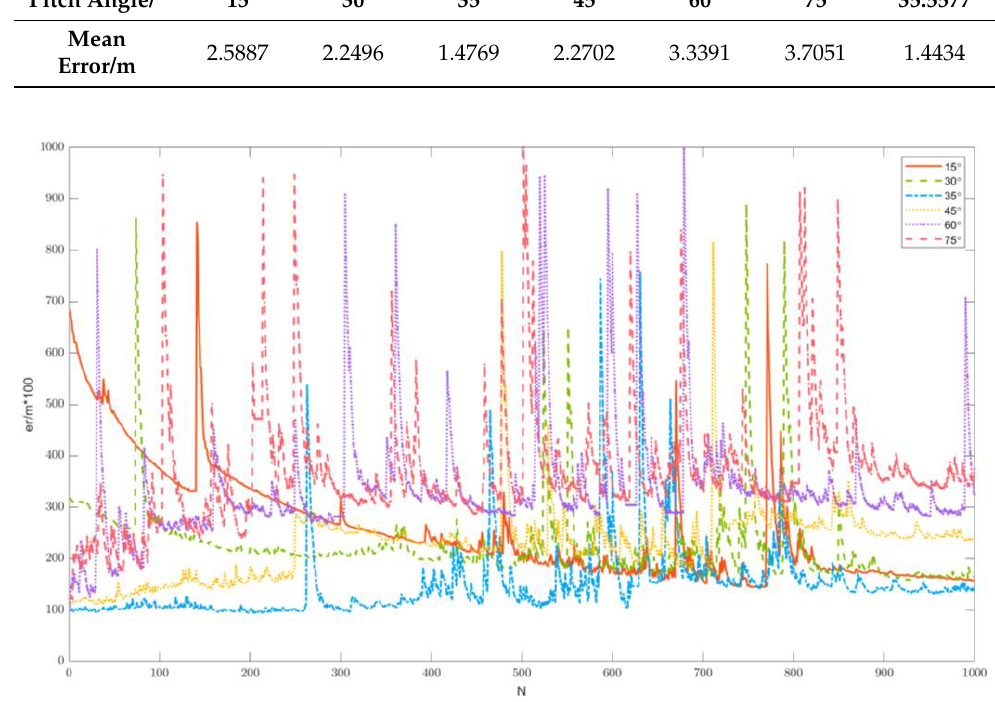
Figure 6. Comparison of errors for different values of pitch angle.